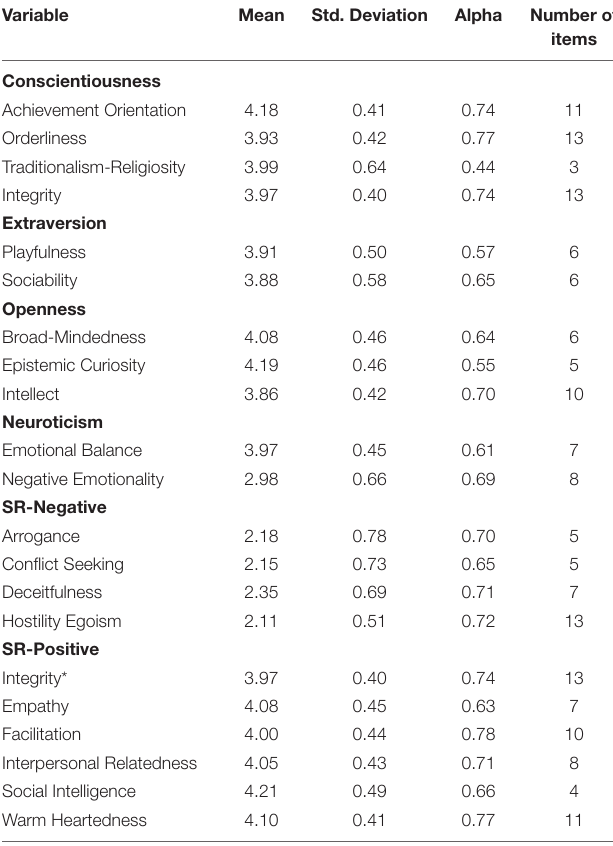
TABLE 4 | Descriptive statistics of the SAPI-VE